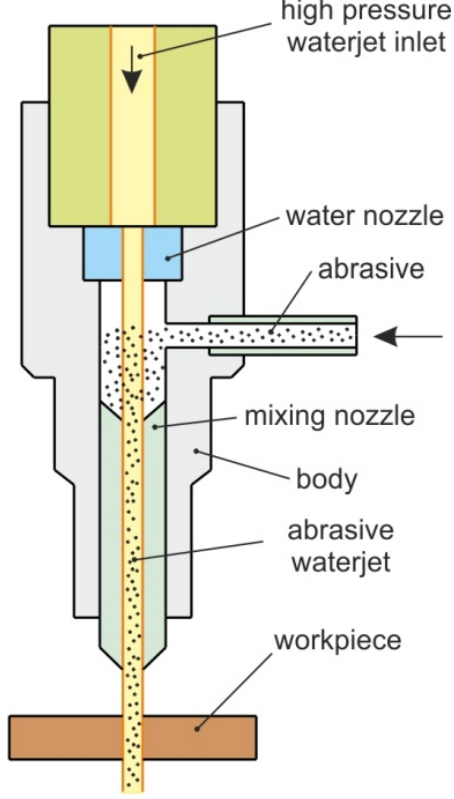
Figure 4. Construction of a typical AWJ cutting nozzle.